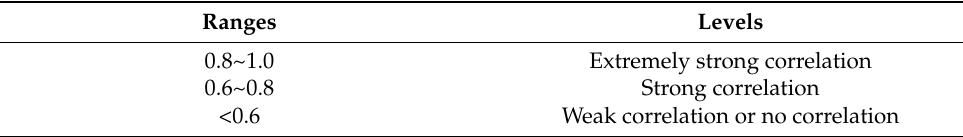
Table 1. Relevance classification rule table.